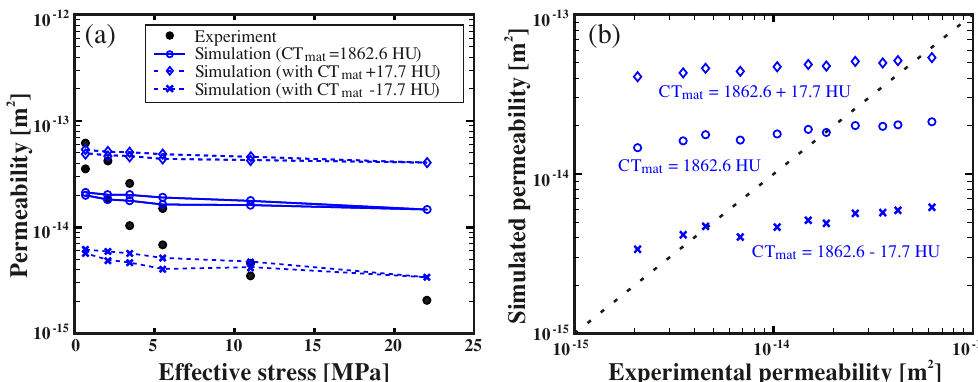
Figure 7. (a) Measured and simulated permeabilities of the entire core sample versus effective stress. Simulation results are obtained by forward modeling (cf. Eq. 3) and by changing CT mat according to the mean standard deviation of the CT measurements (cf. Eq. 7) and (b) corresponding deviations between experimental and simulated permeabilities indicating a systematic